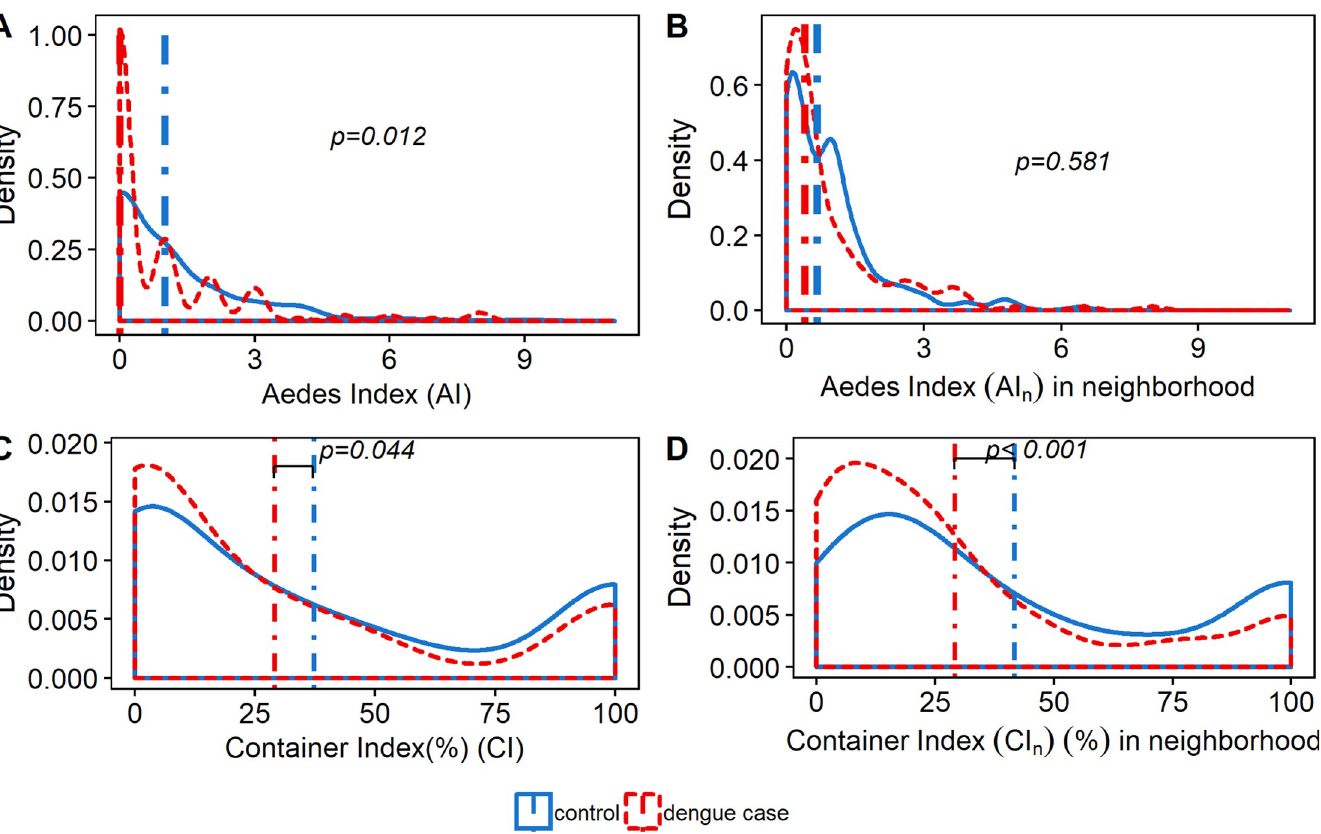
Fig 4. Distribution of adult and immature Aedes indices in dengue case (red line) and control (blue line) houses. Probability density distribution plots of Aedes Index (AI) at the patient house ( A ) and at the neighborhood level (including patient house) ( B ); and of the Container Index (CI) at the patient house (C) and at the neighborhood level (including patient house) (D) . The blue and red vertical lines in A and B represent the median Aedes indices in control and dengue case house, respectively. The blue and red vertical lines in C and D represent the mean container indices in control and dengue case houses, respectively. P-values were calculated using univariable logistic